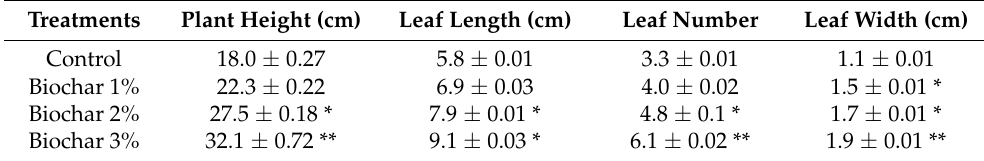
Data are means of three replicates ( n = 3), asterisks indicate significant differences from the control at p < 0.05, <0.01. The shoot and root dry weights showed that the biochar treatments improved both the shoot and the root dry weight compared to the control (Figure 2). The 1% biochar treatment significantly increased shoot dry weight by 51% compared to the control.